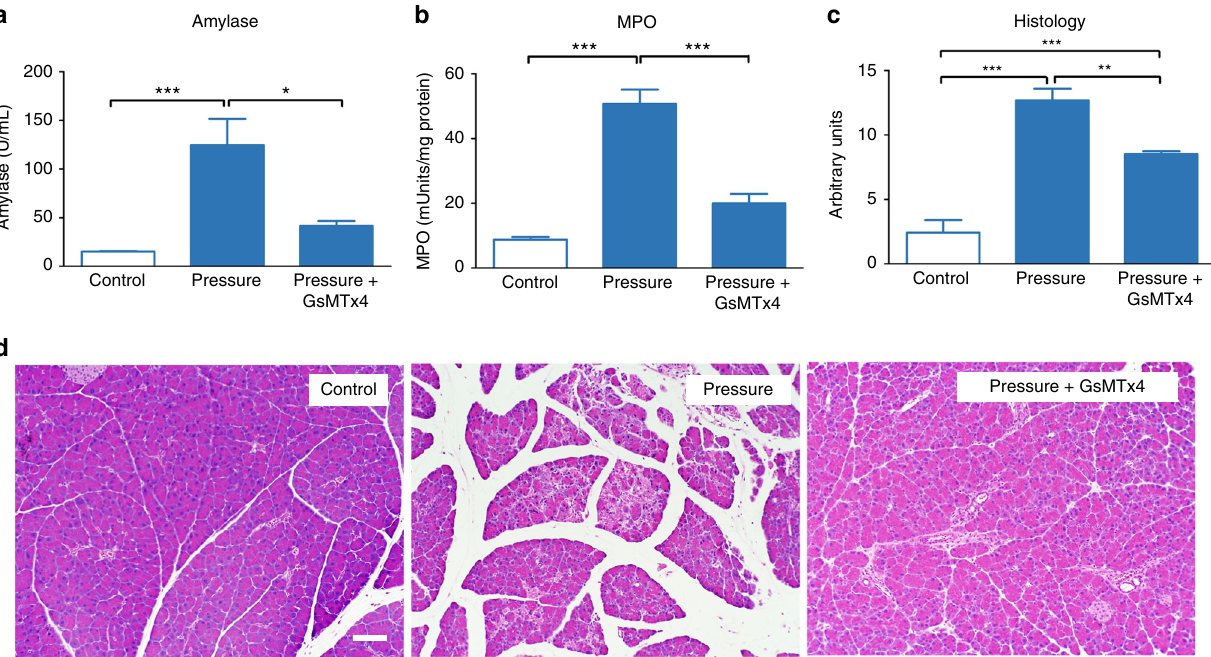
Fig. 3 The Piezo1 antagonist GsMTx4 reduces the severity of pancreatitis. C57BL/6J mice were either sham-operated (control) or received intrapancreatic duct infusion of buffered saline at 25 – 33 mm Hg (pressure). GsMTx4 (270 µ g/kg) was administered by intraperitoneal injection 1 h prior to intrapancreatic duct infusion of saline at 25 – 33 mm Hg (pressure + GsMTx4). a Blood amylase, b pancreatic MPO, and c histological scoring of pancreatitis severity were measured. Statistical analysis was performed using ANOVA test with Tukey ’ s post-test. * P ≤ 0.05; ** P ≤ 0.01; *** P ≤ 0.001 ( n = 6). d Representative images of pancreatic tissue stained with H&E. Bar = 100 µ